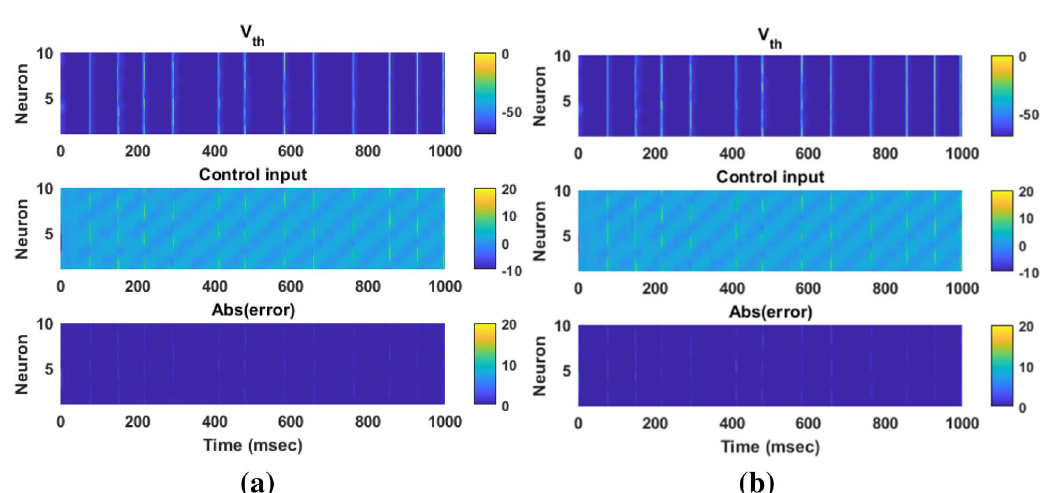
Figure 5. Typical results of the membrane potential, control input, and absolute tracking error for individual cells of the TH populations using ( a ) AFTSMC ( b )